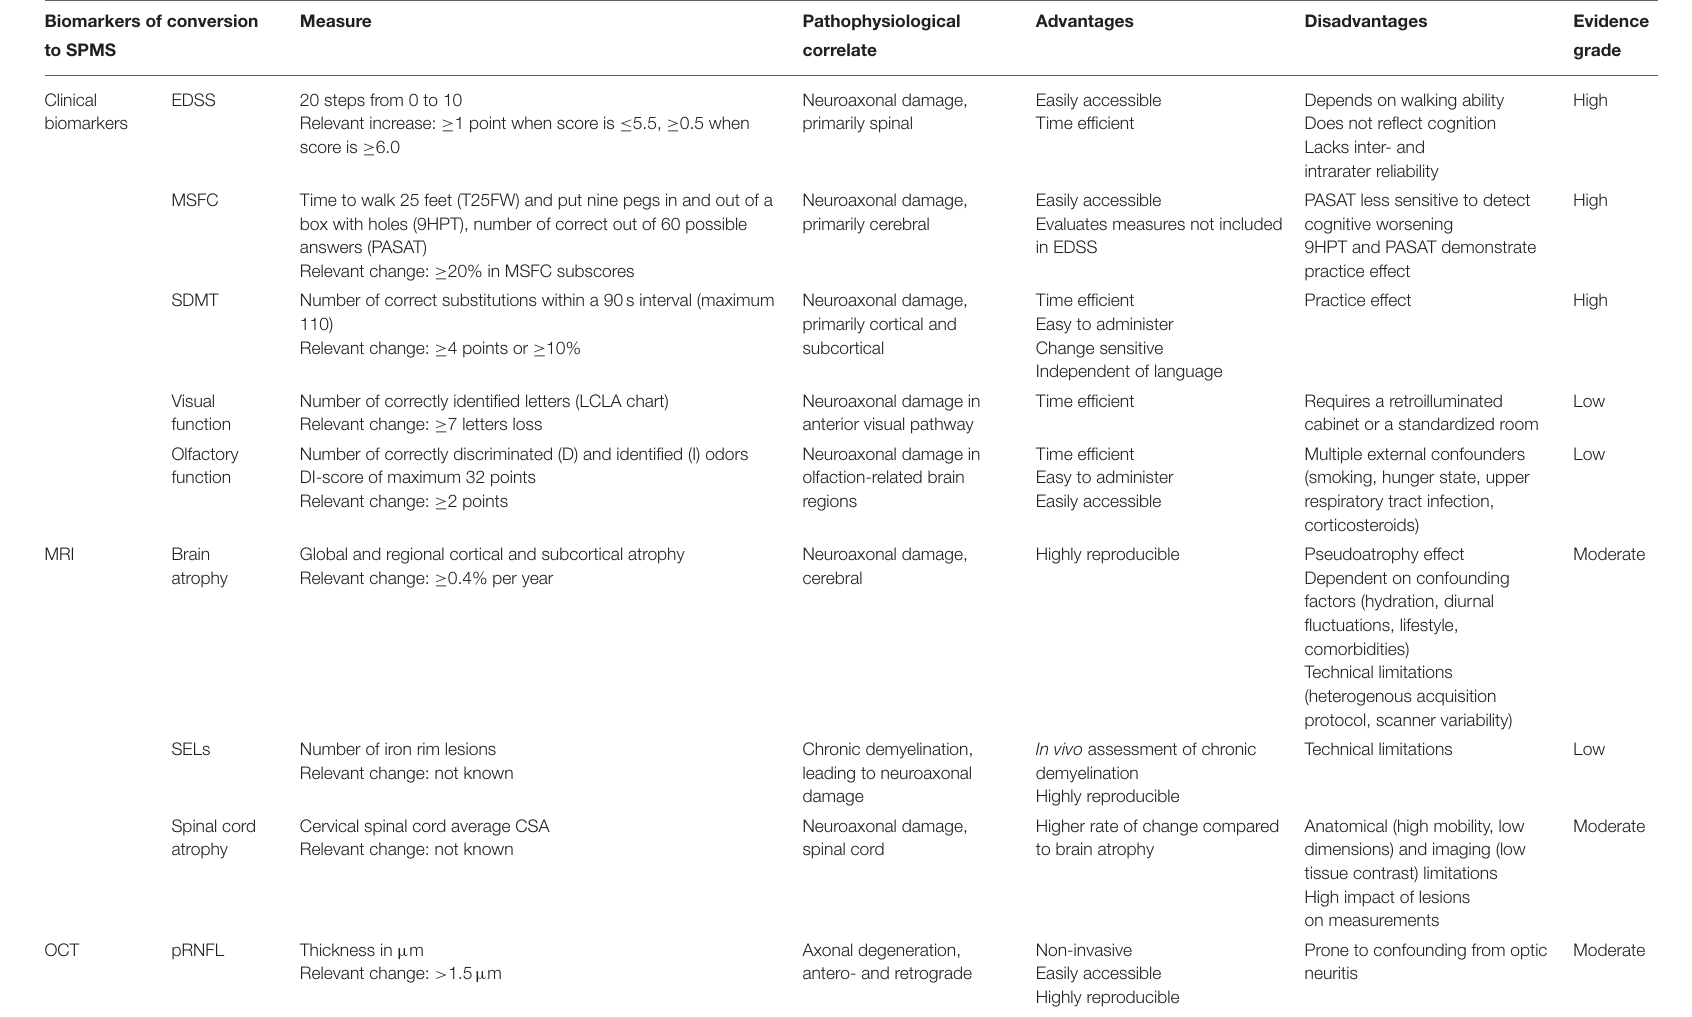
TABLE 2 | The clinical and paraclinical biomarkers of conversion to secondary progressive multiple sclerosis (SPMS). Biomarkers of